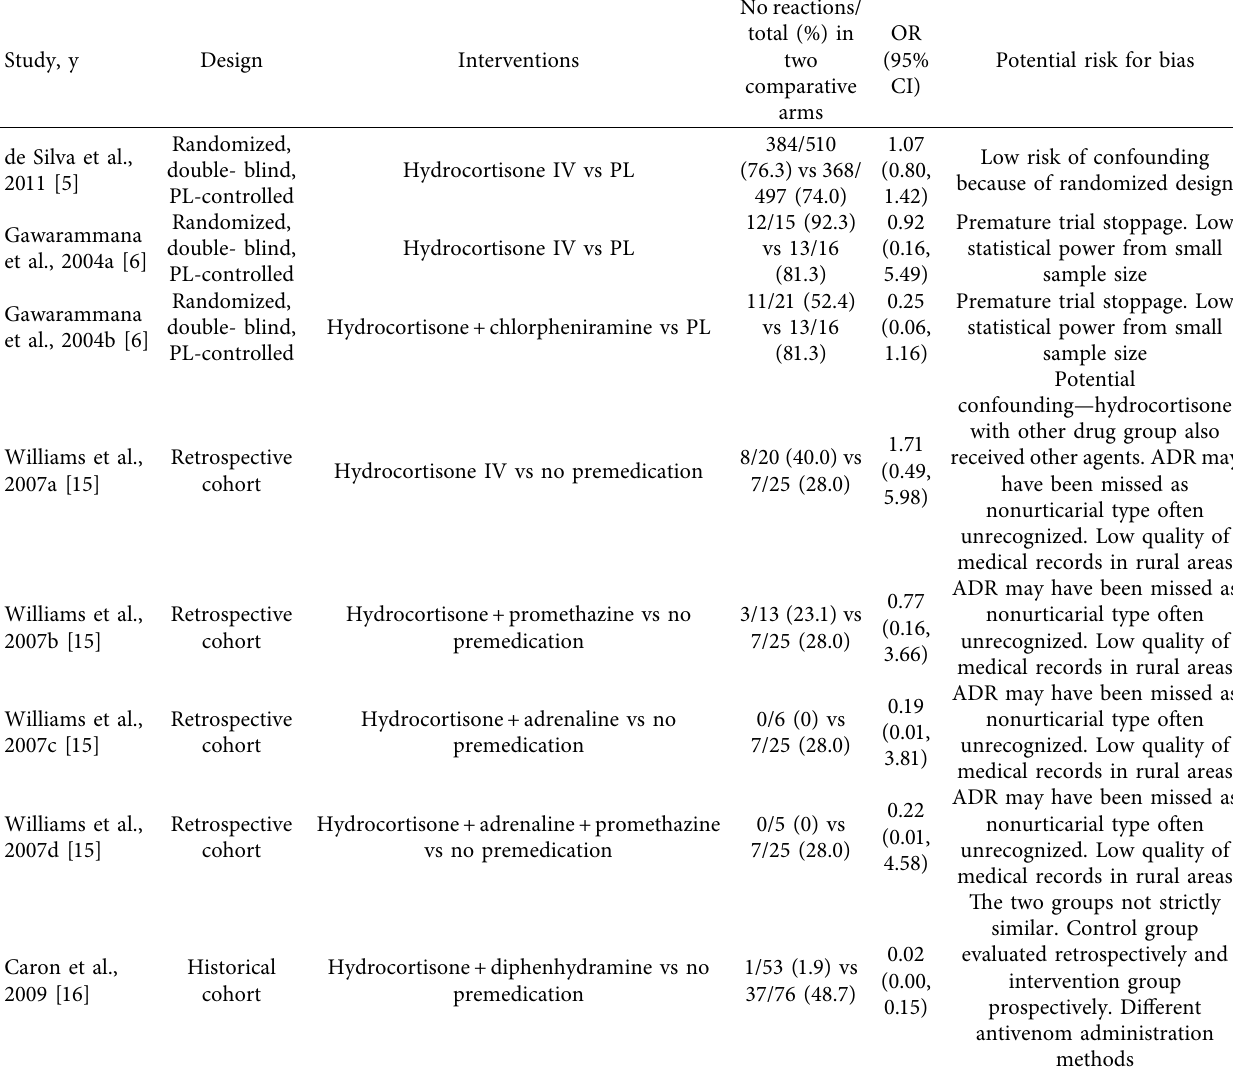
Table 1: Characteristics of included